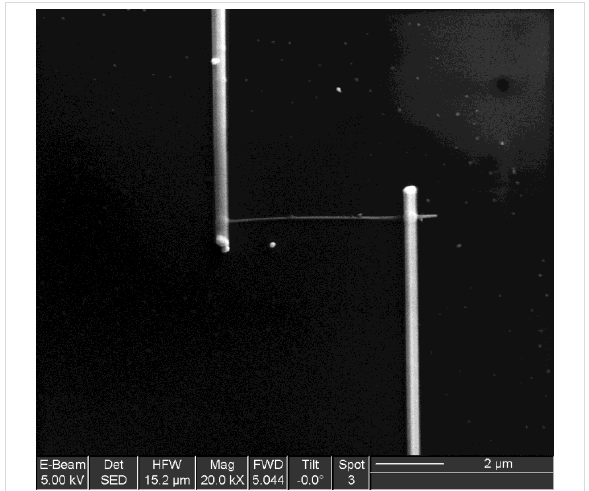
Figure 3: Nanowire with electrical